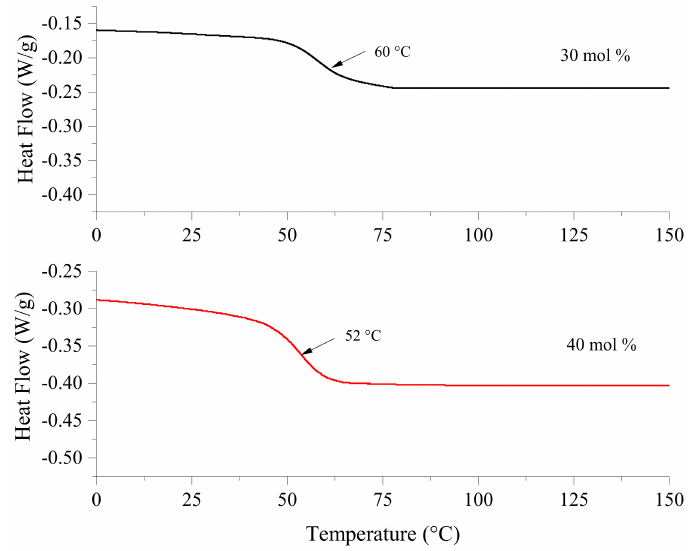
Figure 5. DSC thermograms of the polymers obtained by photopolymerizing formulation with 30 mol % and 40 mol % of TES including the curing agent LCA.